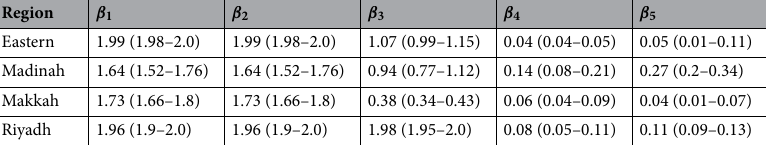
Table 3. Estimated transmission rate in Saudi Regions.